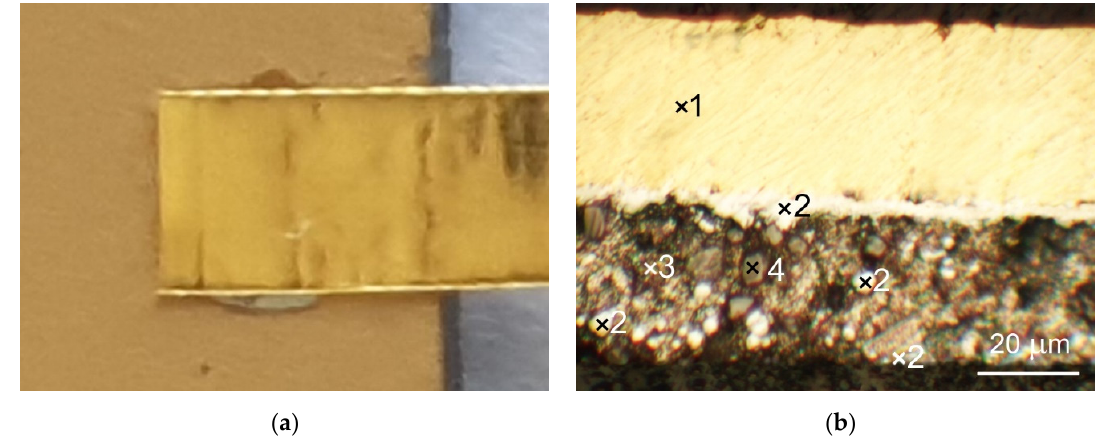
Sensors 2021 , 21 , x FOR PEER REVIEW Figure 8. Microscopic pictures of a sample B: ( a ) overall view of joint; ( b ) cross-section of joint with phase composition of different areas: 1—Au; 2—30.7 at.% Au, 69.3 at.% In; 3—In; 4—79.6 at.% In, 20.4 at.% O.